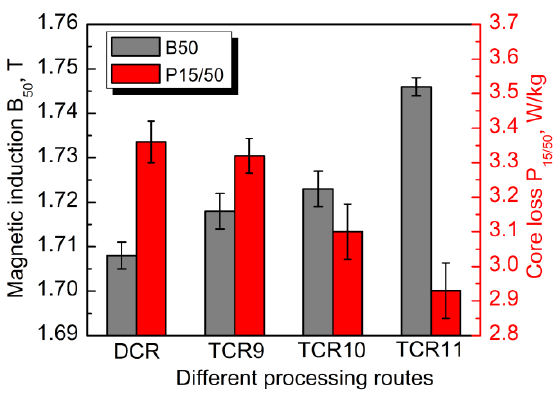
Figure 12. Average magnetic properties of the final anneal sheets produced by different rolling processes.